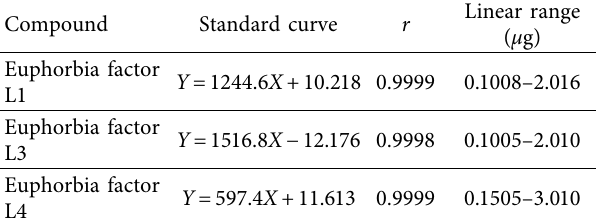
Table 4: Standard curve of euphorbia factor L1, L3, and L4.